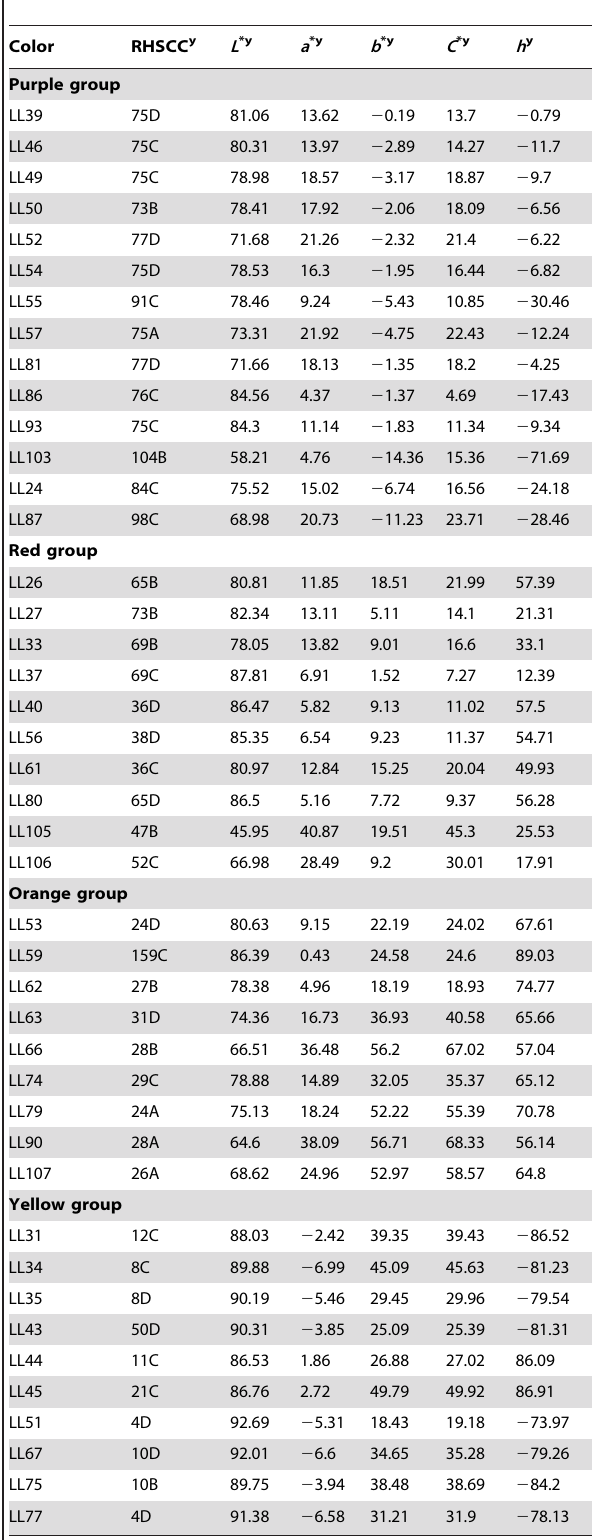
Table 1. Petal colors and color parameters of 44 Lycoris longituba